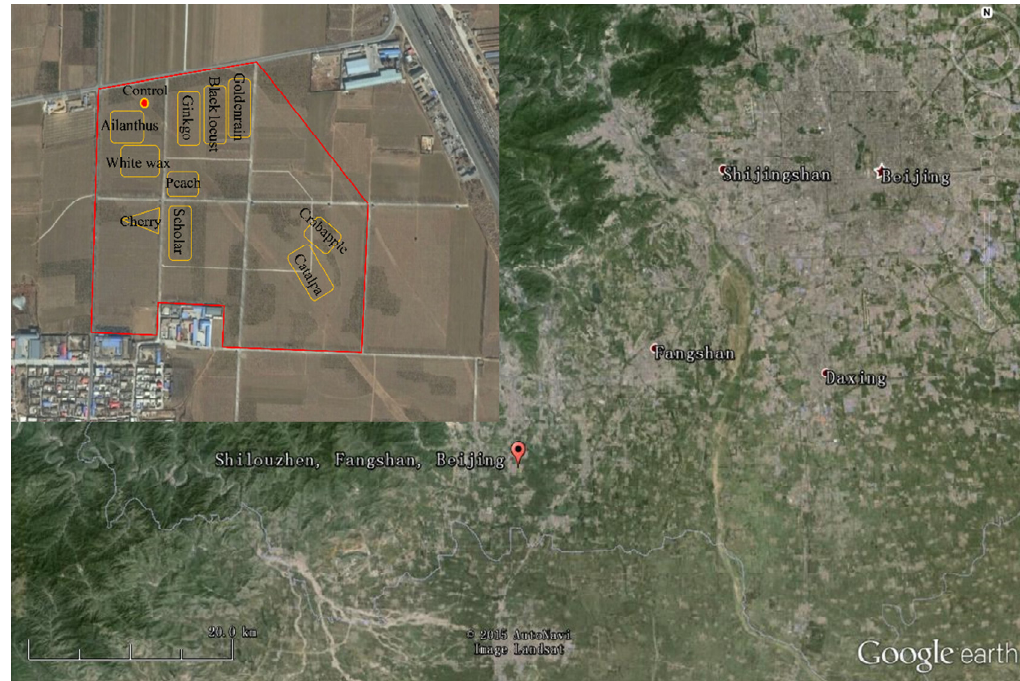
Figure 1. Inset map shows the layout of the sample experimental field. The larger map shows the site vicinity southwest of Beijing. Sources: Google Earth.